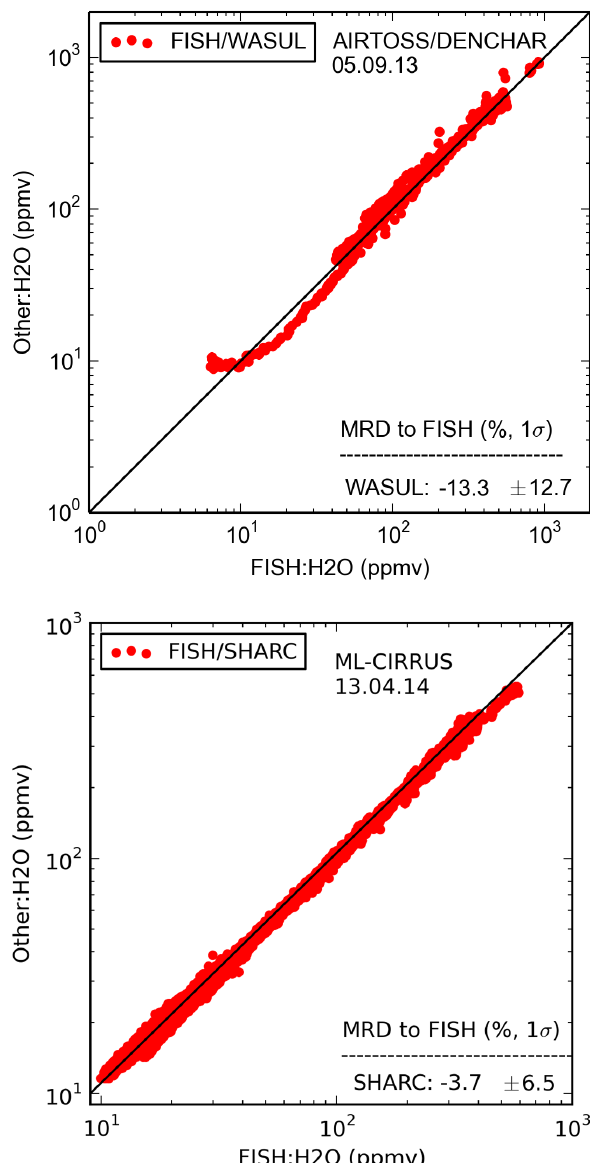
Figure 10. Scatterplot of FISH–WVMR vs. WASUL (red) dur- ing Airtoss/DENCHAR 2013 (top panel) and SHARC during ML- Cirrus 2014 (bottom panel). The mean relative deviation (MRD) with SD from FISH is given for each individual